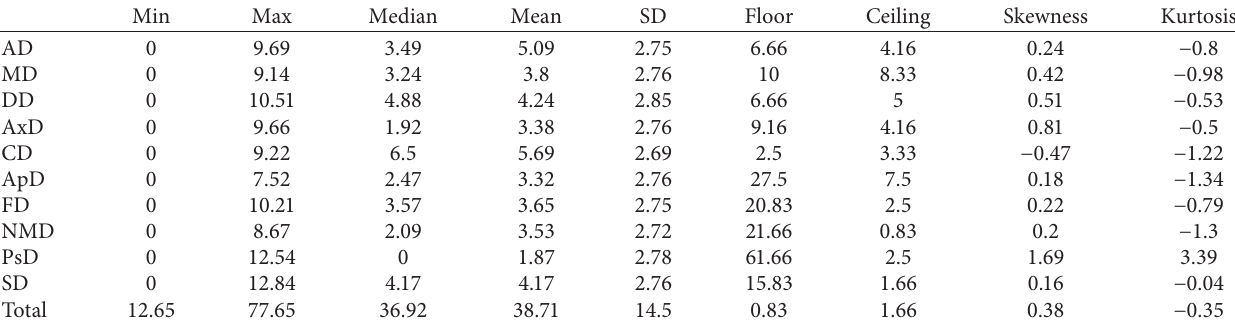
Table 5: Acceptability data of the variables of the Parkinson’s Disease Gravity Index.